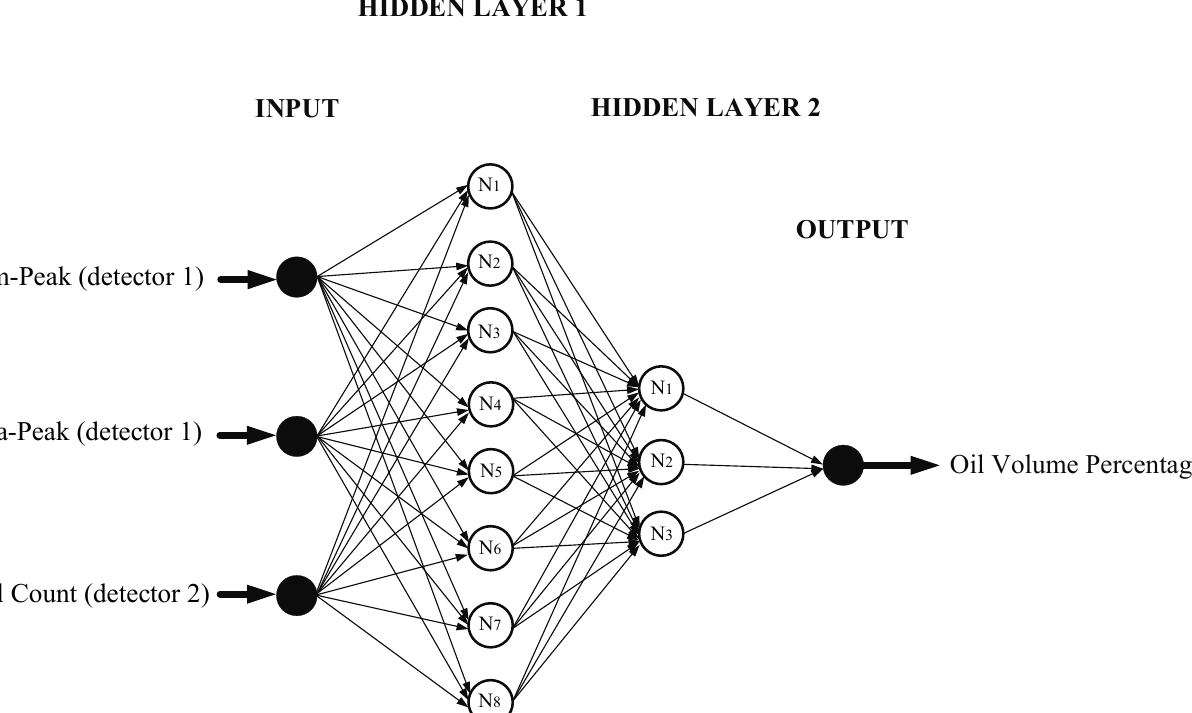
Figure 4. MLP Neural network for predicting oil volume percentage. Table 1. The specifications of predictor MLP neural networks.